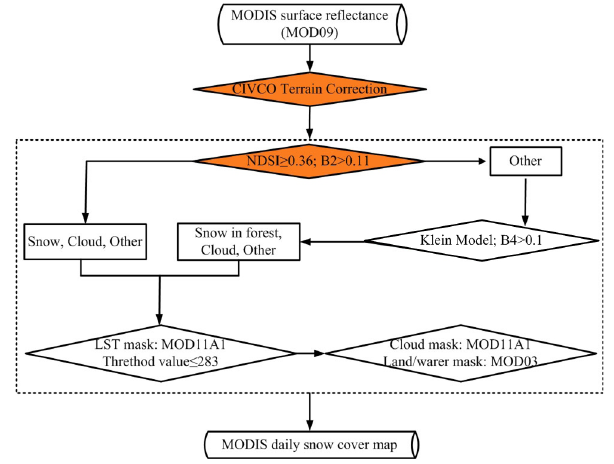
Fig. 2. The flow process of MODIS daily snow cover map algo-